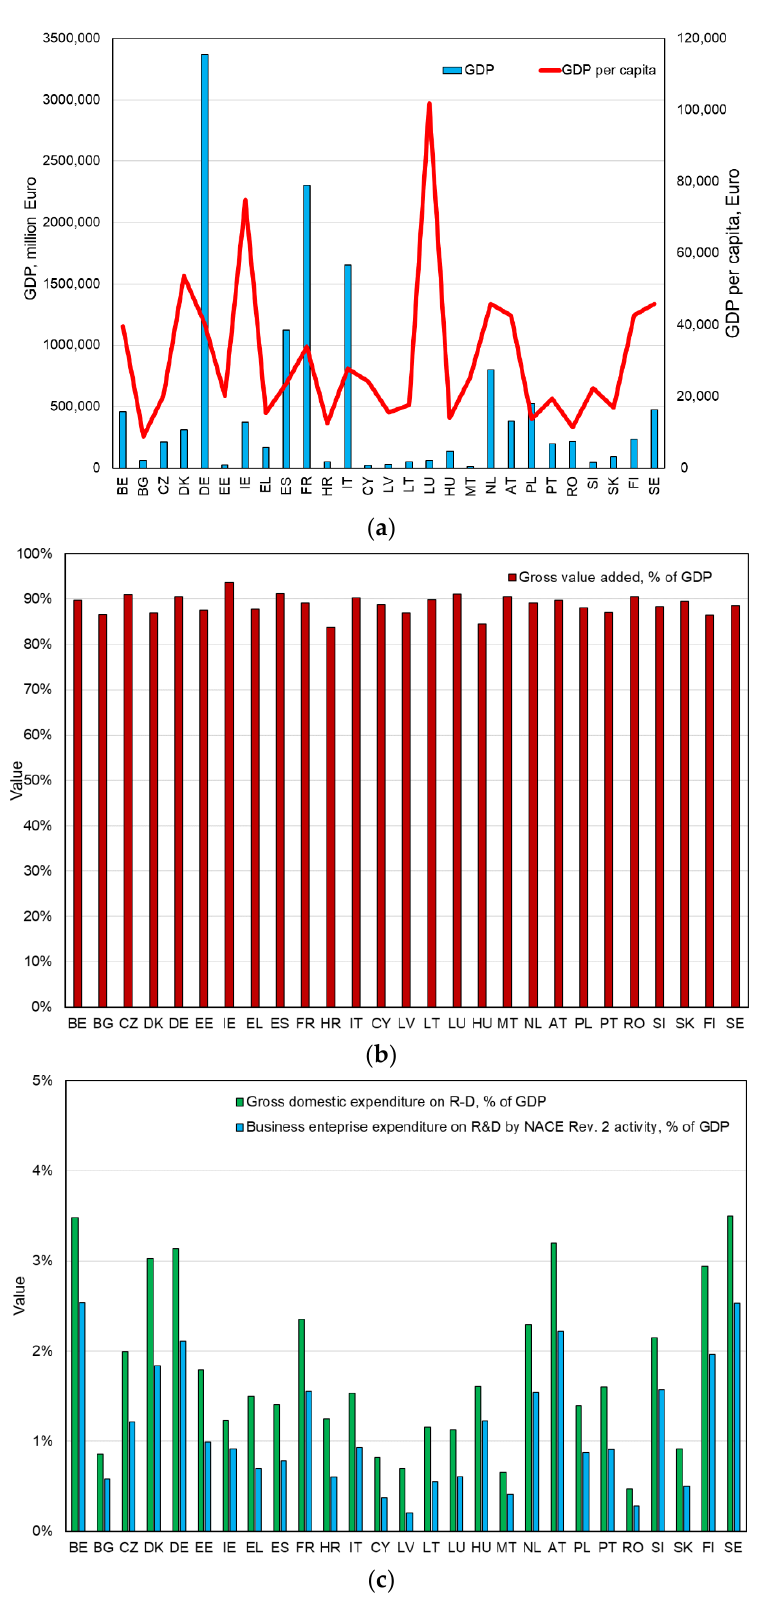
Figure 5. Basic economic parameters of EU-27 adopted for the study (own elaboration based on [78]) (( a ) — value of GDP and GDP per capital; ( b ) — gross value added; and ( c ) — value of gross domestic expenditure on R&D (as % of GDP) and business enterprise expenditure on R&D by NACE Rev. 2 activity).